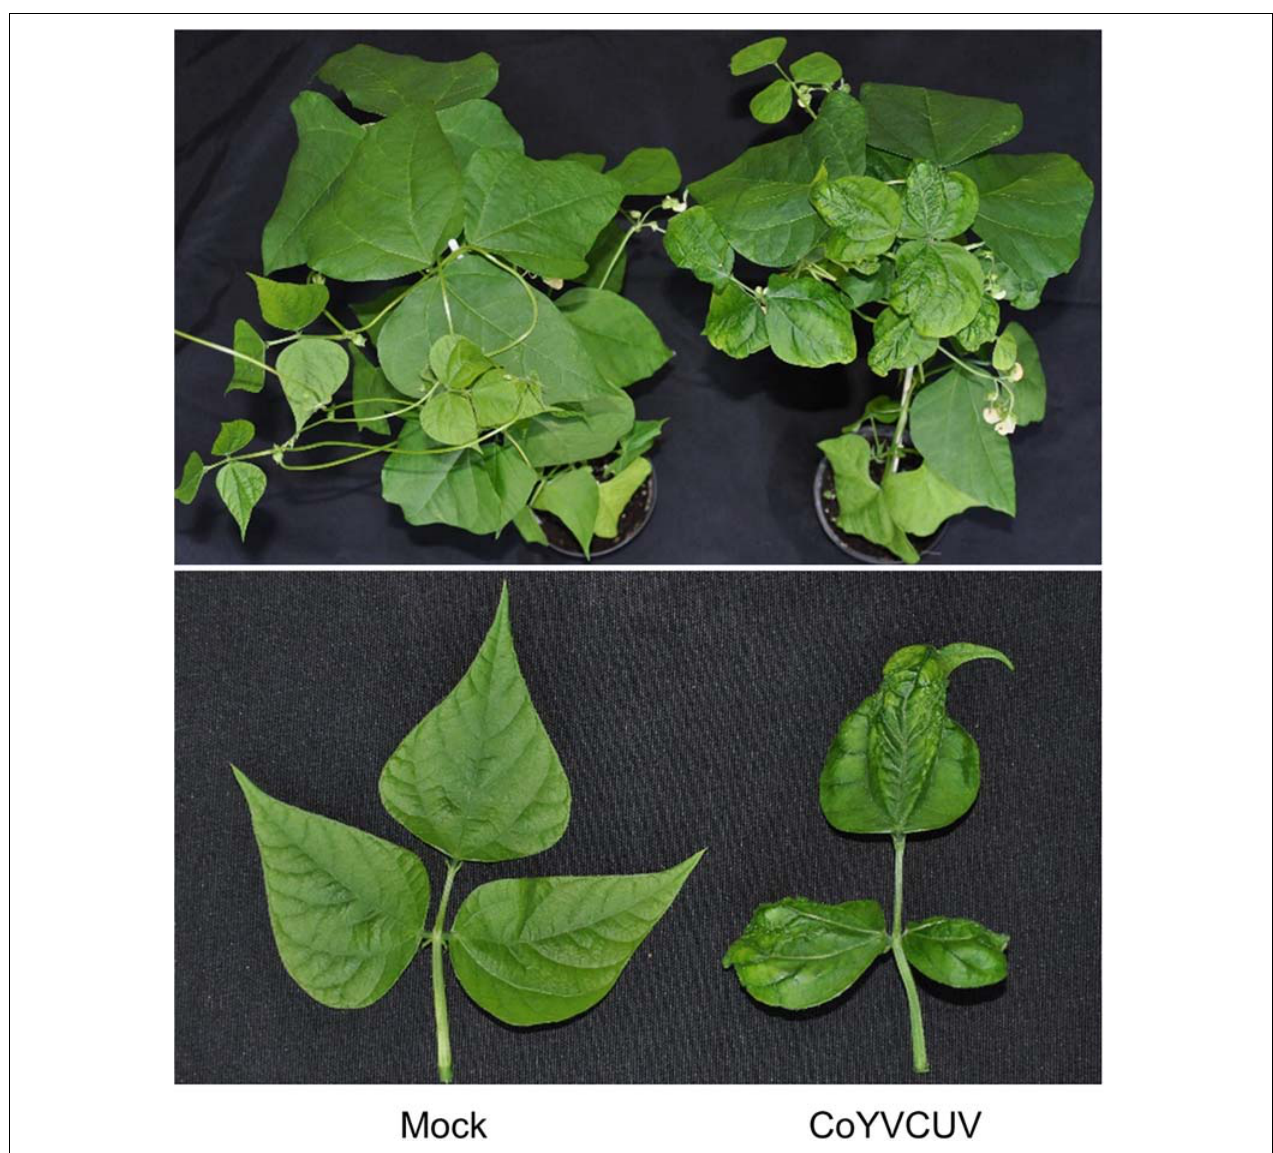
FIGURE 5 | Symptoms of leaf crinkle and mild yellowing developed in common bean plants agroinoculated with Corchorus yellow vein Cuba virus (CoYVCUV) DNA-A. Mock-inoculated controls are shown at the left of each